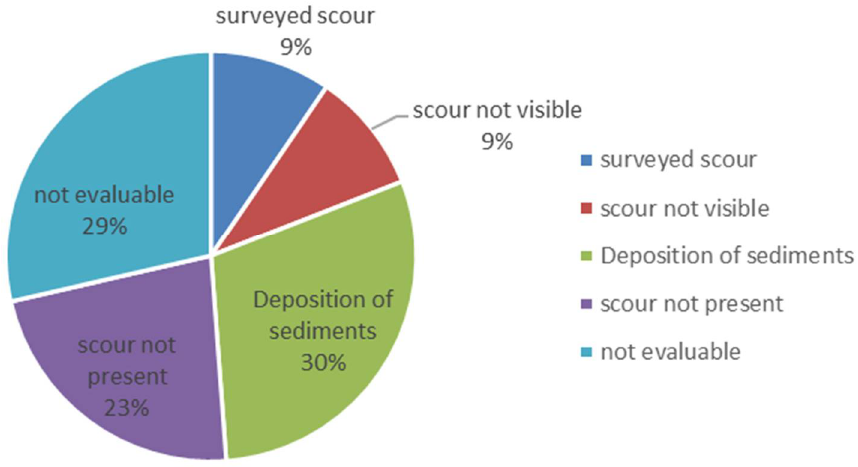
Figure A8. Observations of scour collected during onsite inspections of the bridges.